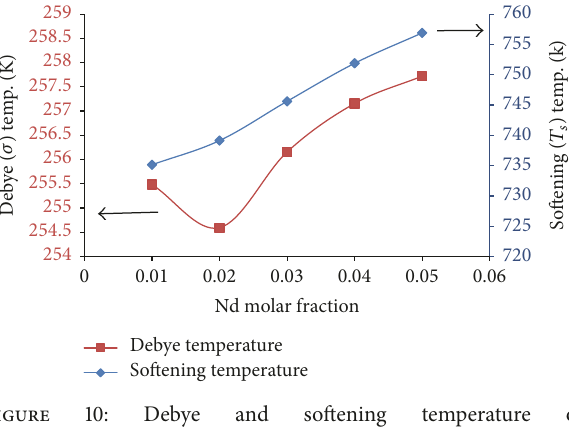
Figure 7: Fractal bond connectivity of [(TeO 2 ) 0.70 (ZnO) 0.30 ] (1−𝑥) (Nd 2 O 3 NPs) (𝑥) glasses.